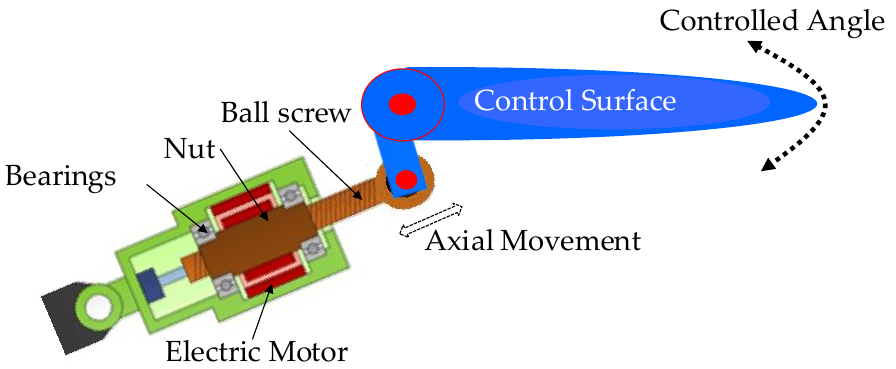
Figure 1. Illustration of a direct-drive EMA for actuating a flight control surface. Garinei and Marsili in [6] developed a statistical diagnosis method for monitoring a damaged ball and return channel of a ball-screw actuator. A Hall effect sensor was mounted on the ball return channel for monitoring the motion’s smoothness of the balls. The statistical distributions of the Hall sensor data were estimated for different fault conditions in order to decide the health